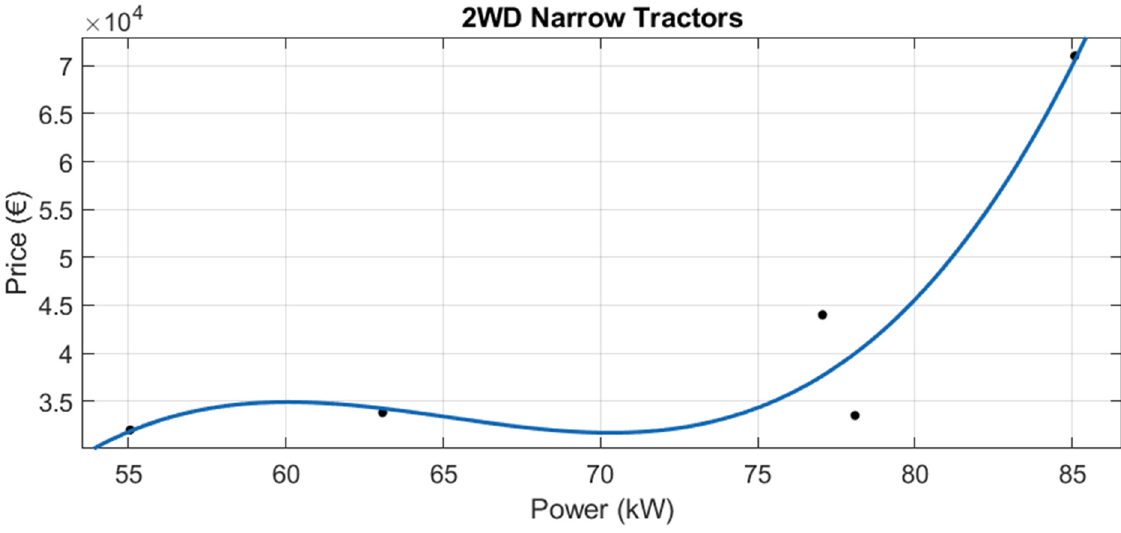
Figure 18. Price vs. power for 2WD normal width new tractors.